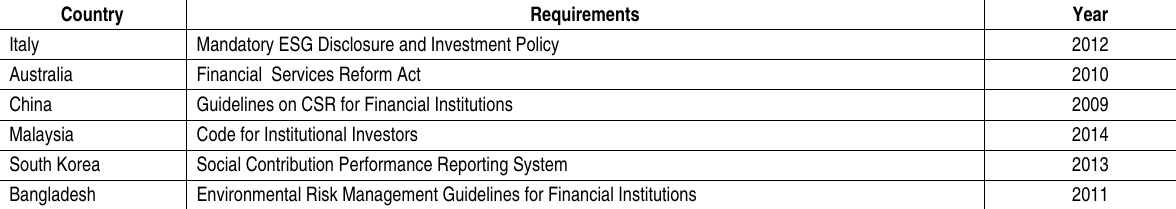
Table 4 (cont.). Regulatory instruments for mandatory SR disclosure in financial sector